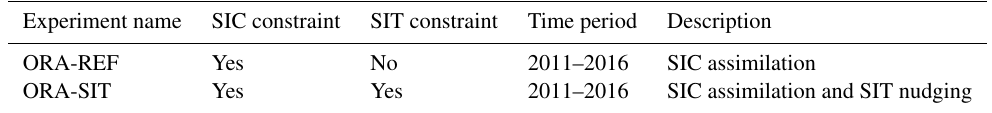
Table 1. Specifications of the ocean–sea-ice assimilation